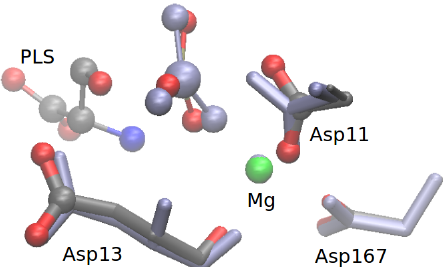
Figure 6. Superposition of the computed transition structure (coloured) with the crystal structure of the transition state analogue (1L7N) AlF 3 -PSP (blue). The phosphate adopts a trigonal planar configuration with the oxygen atoms of nucleophile (Asp11) and leaving group (PLS) at apical positions of a bipyramid. The P–O distance of the computed structure is ∼ 0.3 Å longer than the Al–O distance in the crystal.